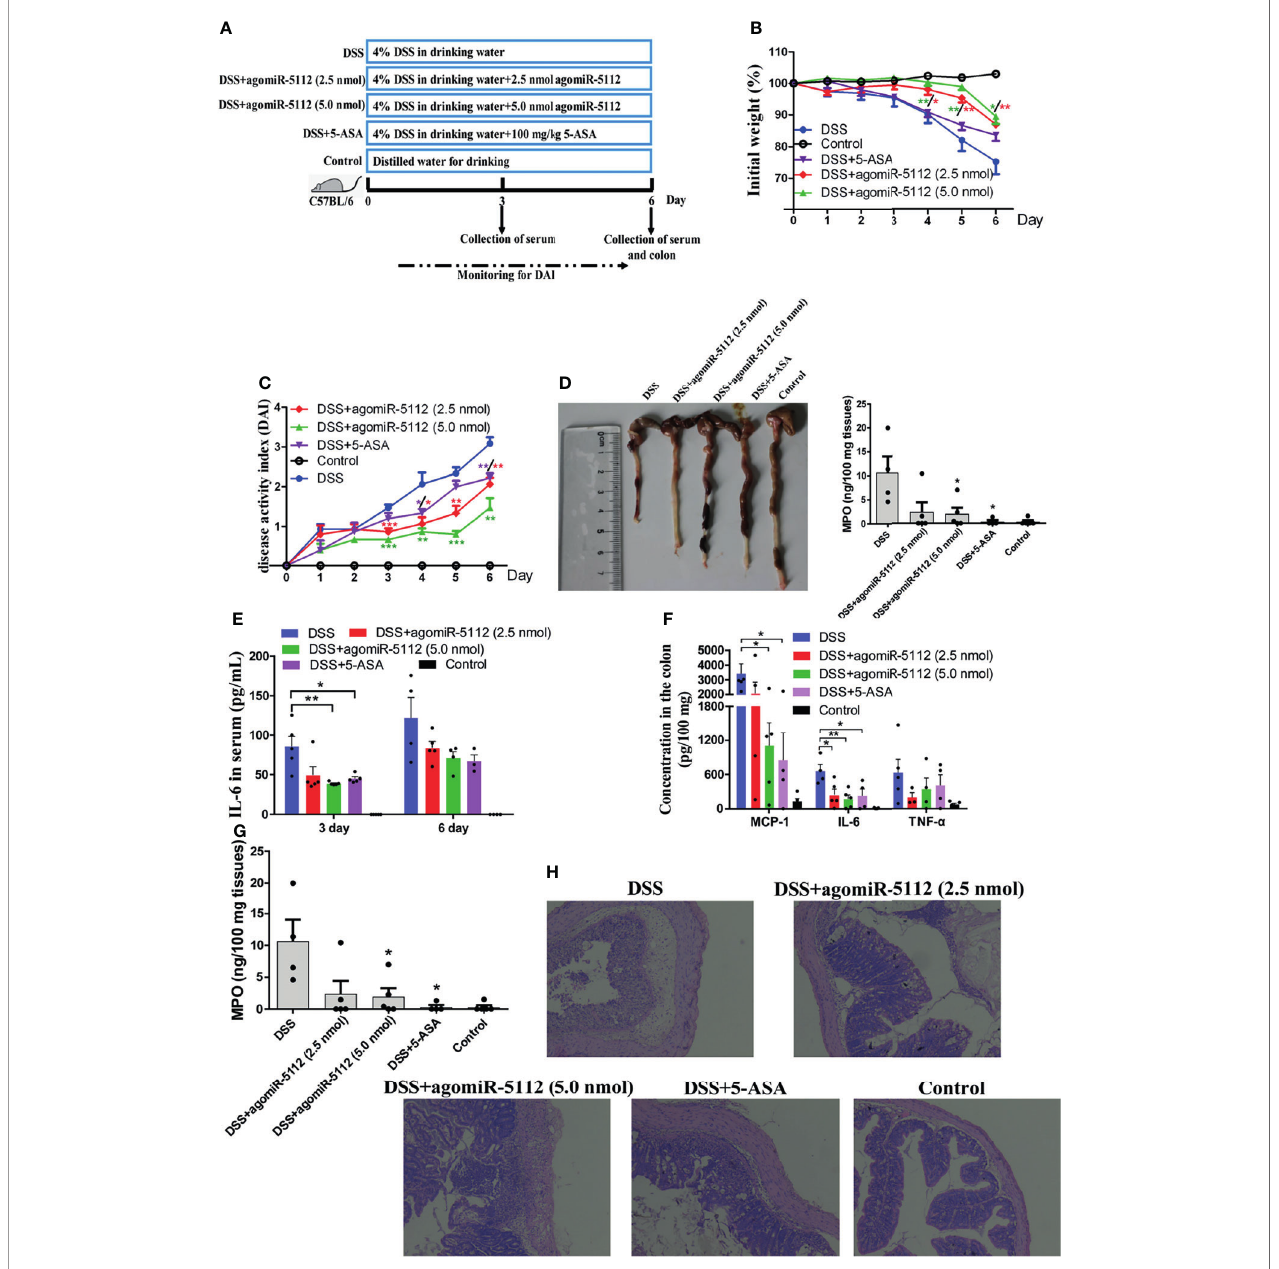
FIGURE 7 | Exogenous miR-5112 agomiR alleviates DSS-induced colitis in mice. The colitis model was induced with 4% DSS in C57BL/6 mice (n=5/group). The therapeutic effect of agomiR-5112 on colitis was evaluated. 5-ASA was used as a positive control to treat the colitis. (A) Schematic diagram of the experimental design for 4% DSS-induced colitis and treatment. (B) Changes in the body weight of mice were recorded during DSS exposure. The weight changes were calculated as a percentage of the initial weight. (C) DAI was recorded to evaluate the severity of colitis during DSS exposure. DAI = (weight loss score + diarrhea score + bleeding score)/3. (D) The colon was photographed and its length was measured at 6 d after DSS induction. Cytokines in serum (E) and colon tissues (F) were determined using the BD ™ CBA Mouse In fl ammation Kit. (G) MPO levels in the colon were also determined using the Mouse MPO ELISA Kit according to the manufacturer ’ s instructions. (H) Histological analysis of the mouse colon at 6 d after DSS induction was examined by H&E staining. The results were observed at 100× magni fi cation using an optical microscope. All data are expressed as the mean ± SEM. * P < 0.05; ** P < 0.01; *** P < 0.001 versus DSS